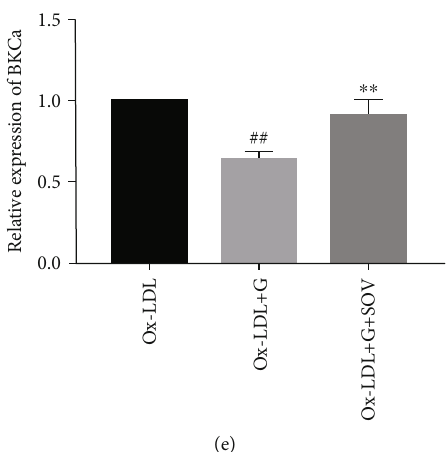
Figure 6: E ff ects of genistein on BKCa currents and protein expression after preincubation with SOV. (a) Representative BKCa currents recorded in each group. (b) I ‐ V curves of BKCa currents. (c) BKCa peak current densities at the test potential of -80 mV. The data indicated that genistein inhibits Ox-LDL-mediated BKCa currents. The inhibitory e ff ects of genistein were reversed by SOV. ∗ P < 0 : 05 vs. Ox-LDL group. (d) Western blot analysis and (e) statistical analysis of BKCa channels. The result indicated that genistein inhibits the expression of BKCa channels. The inhibitory e ff ects of genistein were reversed by SOV. ## P < 0 : 01 vs. Ox-LDL, ∗∗ P < 0 : 01 vs. Ox-LDL+G. All the results are expressed as the mean ± SD ( n = 3 ). Abbreviations: G: genistein; SOV: sodium